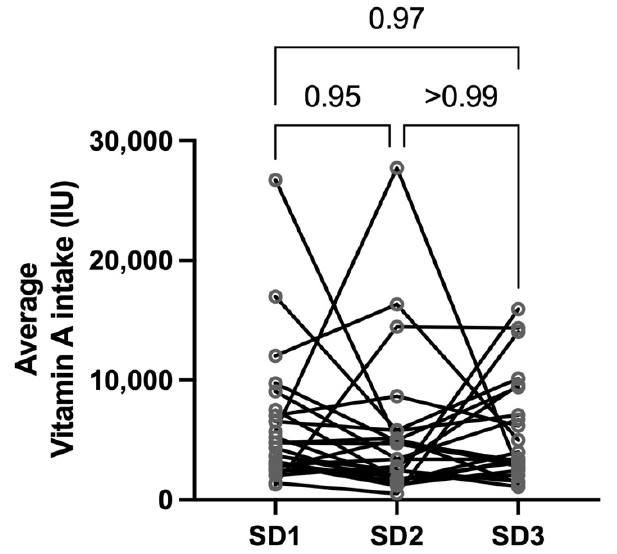
Figure 1. The average vitamin A intake (IU) for each participant was calculated based on self-reported food logs for the three days prior to SD1, SD2, and SD3 visits and were not significantly different between visits.